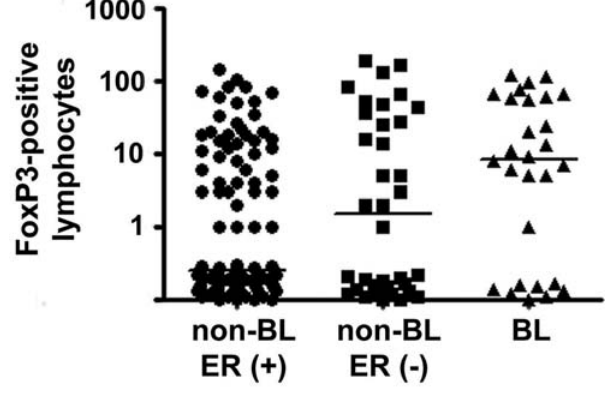
Figure 5. FoxP3-positive lymphocytes in breast tumors. The number of FoxP3-positive lymphocytes is highest in basal-like breast tumors (BL; n=28) when compared to estrogen receptor (ER)-positive breast tumors (non-BL, ER ( + ); n=111) and non-basal-like ER-negative breast tumors (non-BL, ER ( 2 ), n=36). P for trend: 0.0004. Shown is the average FoxP3-positive lymphocyte count per 250 6 field. Solid lines in graph indicate the median. Basal-like breast tumors are defined as being ER-negative, HER2-negative, cytokeratin 5-positive and/or HER1- positive.